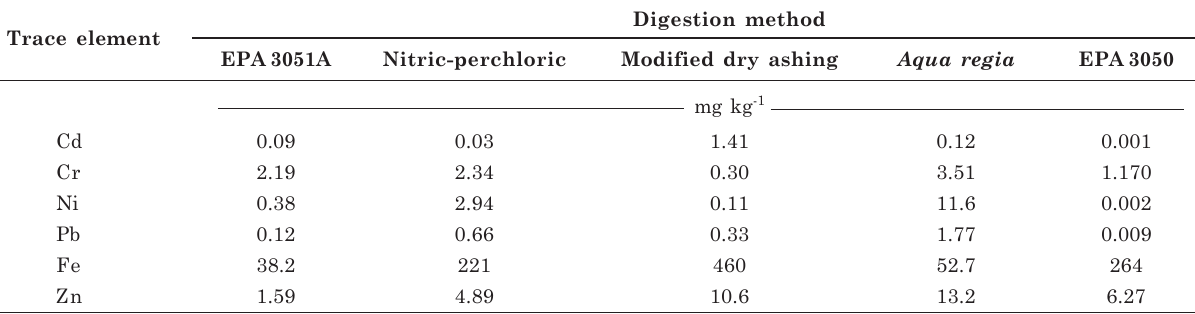
Table 1. Detection limits for the different digestion methods and trace elements in accordance with the five replicates used for blank